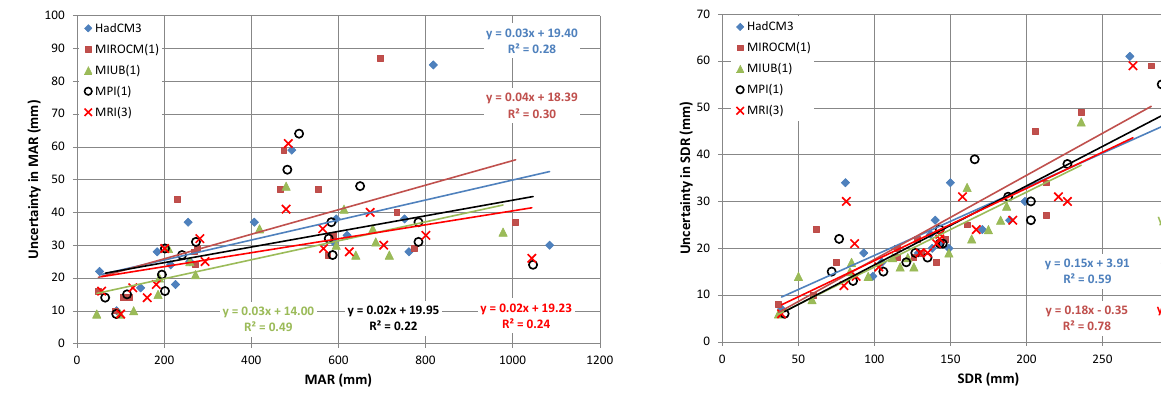
Figure 10. Within-GCM uncertainty (mmyr − 1 ) in mean annual runoff versus mean annual runoff based on 100 PERM runs using replicates of monthly precipitation and temperature (1965–1994, 20C3M) as input from five GCMs.